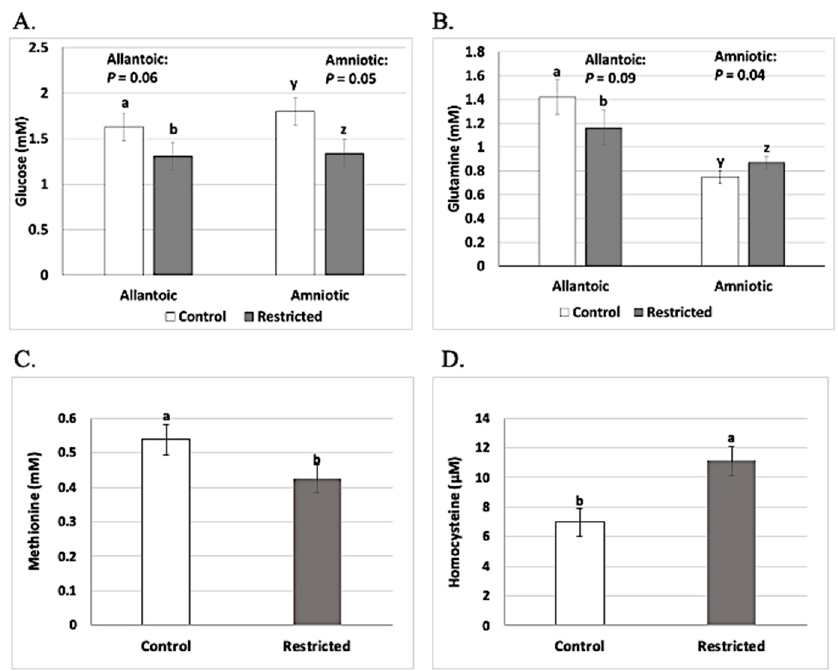
Figure 1. Comparison of ( A ) glucose concentrations in allantoic and amniotic fluid, ( B ) glutamine concentrations in allantoic and amniotic fluid, ( C ) methionine concentrations in allantoic fluid, and ( D ) homocysteine concentrations in maternal serum of heifers receiving control or restricted dietary treatment from the day of mating (d 0) until d 50 of gestation. Treatments provided for 0.5 kg of gain/hd daily vs. − 0.08 kg of gain/hd daily between d 0 and d 50 of gestation for control vs. restricted heifers, respectively. Figure from Caton et al. [1]. a,b and y,z for ( A,B ) bars significantly different, with p -value as indicated; a,b for ( C,D ), bars differ significantly ( p <